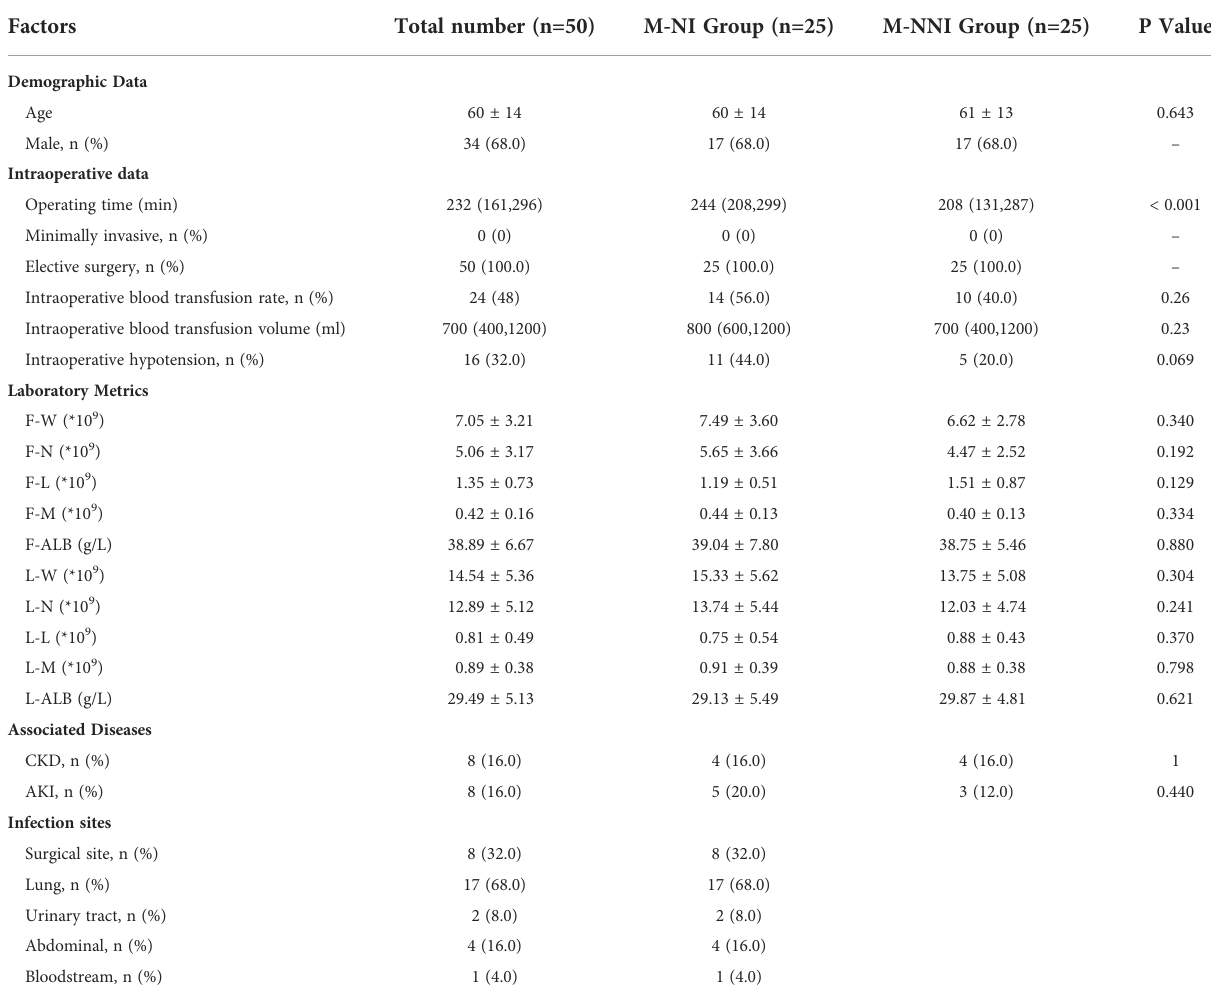
TABLE 1 Characteristics of patients in the M-NI group and M-NNI